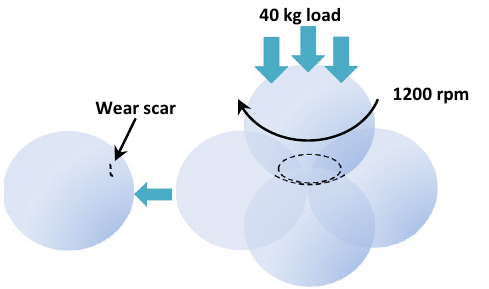
Figure 4. Four ball of tribological system.